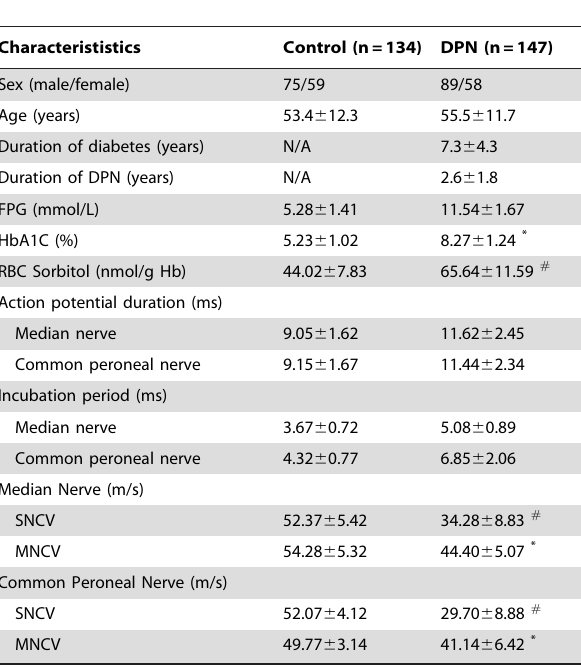
Table 3. Clinical Profiles, Results of Lab study and NCV (Data presented as mean 6